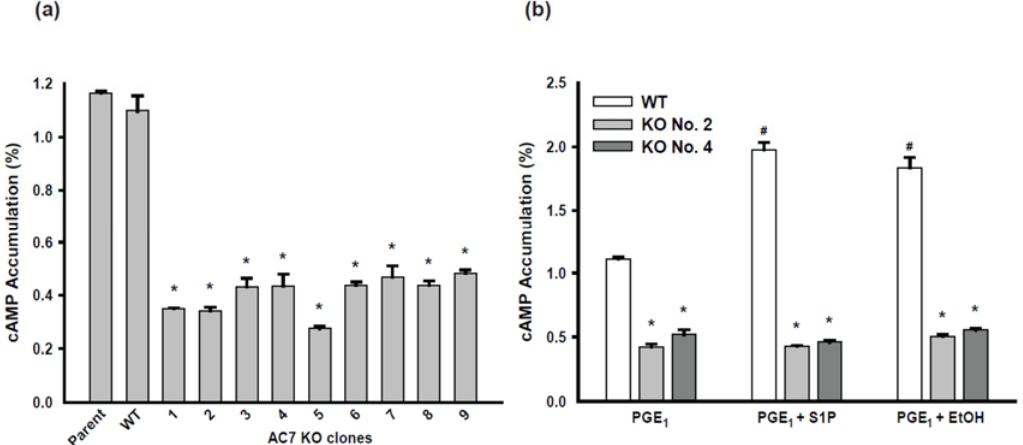
Figure 3. AC activity of AC7 knockout (KO) clones of BV-2 mouse microglial cells. ( a ) Cells were stimulated with 1 µ M PGE 1 for 1 min after 10 min of incubation with 500 µ M IBMX. Data are represented as mean ± SEM in triplicate. The value for the wild-type clone (WT) does not differ from the value of the parental BV-2 cells. * indicates the values for AC7 KO clones No. 1 to No. 9 are significantly smaller than the value of the parental BV-2 cells at p < 0.05 using one-way ANOVA. ( b ) Cells of the WT clone and AC7 KO clones No. 2 and No. 4 were incubated with 500 µ M IBMX for 10 min and stimulated with 1 µ M PGE 1 or PGE 1 plus another stimulant: 100 nM S1P or 200 mM ethanol for 1 min. Data are represented as mean ± SEM in triplicate. * indicates the values of clones No. 2 and No. 4 are significantly smaller than the value of the WT clone at p < 0.05 using one-way ANOVA. # indicates that, for the WT clone, values for PGE 1 plus S1P and PGE 1 plus ethanol are significantly larger than the value for PGE 1 alone at p < 0.05 using one-way ANOVA. There are no significant differences among the three treatment groups in the AC7 KO clone No. 2 and No.